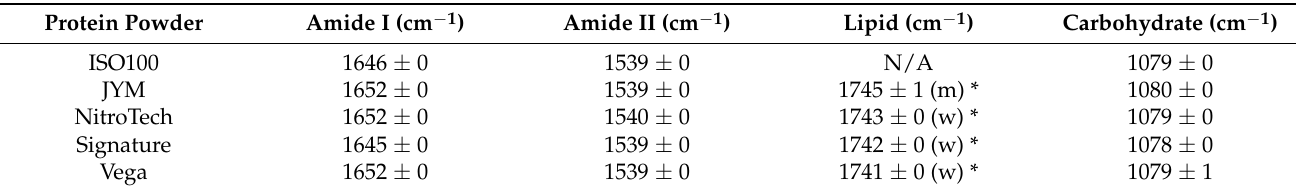
Table 2. MIR data of protein powders in the amide I/II, lipid, and carbohydrate spectral regions. Protein